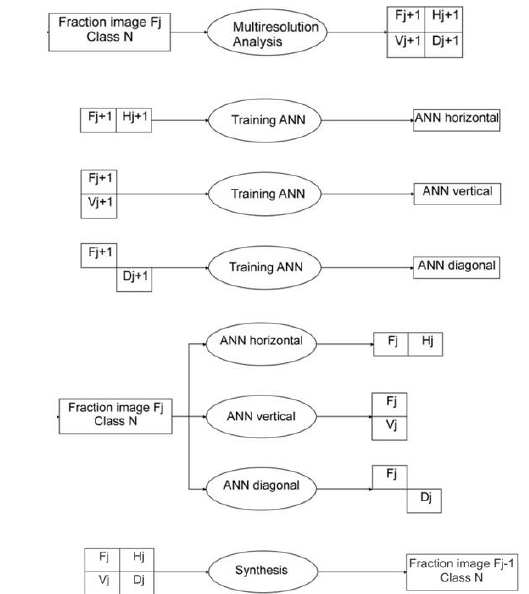
paper, both SAM and SAM with CF constraint (SAM CF) will be